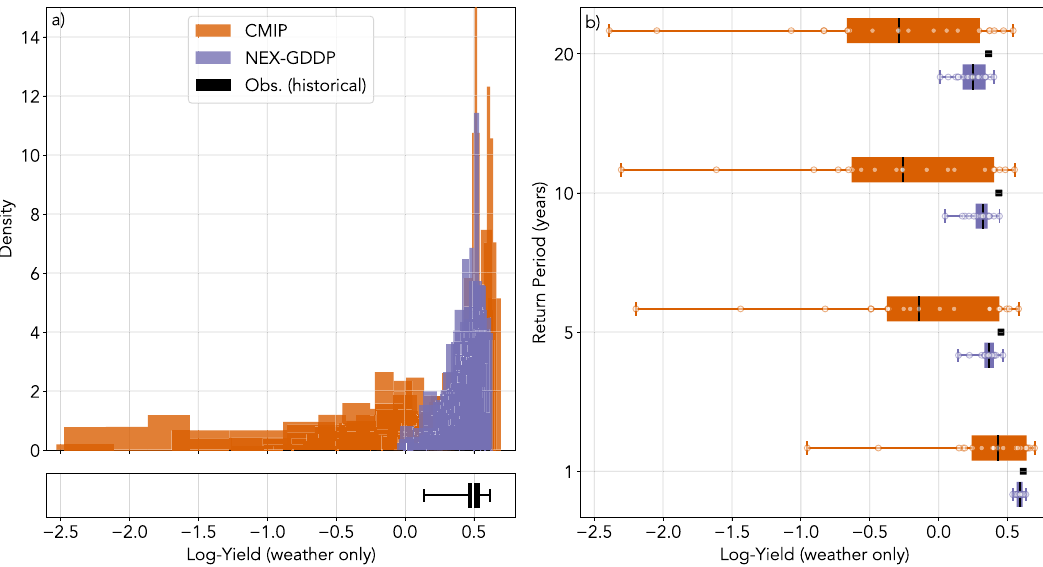
Fig. 5 Projected national-level yield distributions and associated return periods. Panel a shows RCP 8.5 projections of mid-century (2030 – 2059) national-level log-yield distributions. The NEX-GDDP models are shown in purple and the CMIP5 models in orange; the historical observations are also shown as the black boxplot, for reference. Panel b shows the corresponding 1, 5, 10, and 20-year return period values for each model. The historical values are shown for comparison as black points. In the absence of future yearly county-level production shares, we aggregate to the national level by using the mean 1980 – 2020 weights. The boxes extend to the 25th and 75th percentile models, and the whiskers extend the full range of